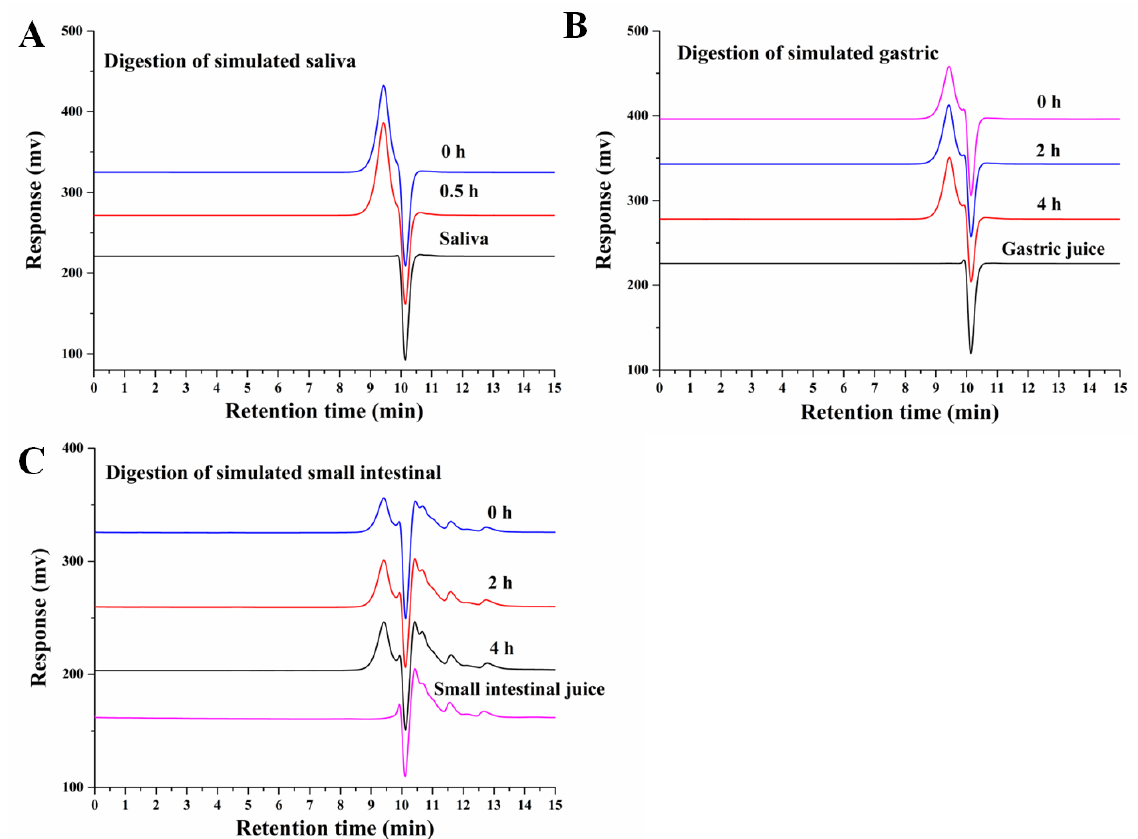
Figure 1. HPGPC chromatograms of polysaccharides. The changes in the molecular weight of AABP-2B during simulated saliva ( A ), and gastric ( B ) and intestinal juice ( C ) digestions.